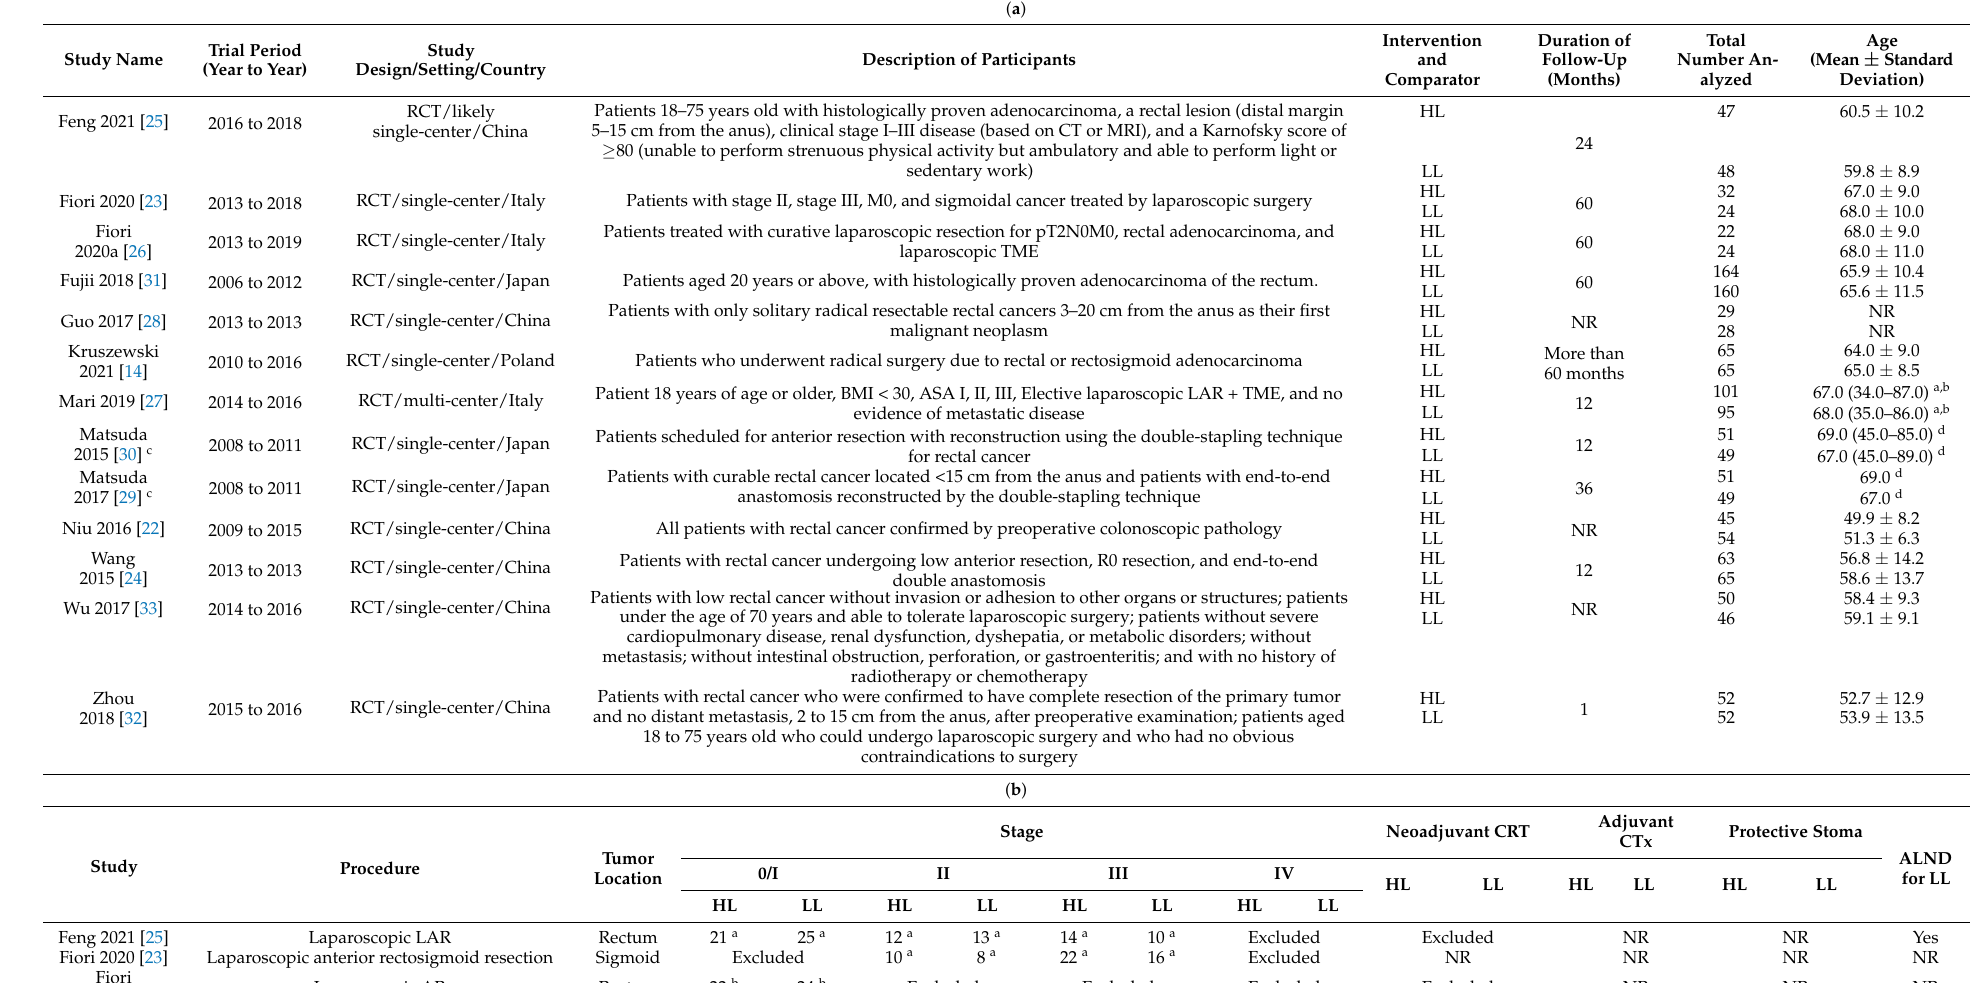
Table 1. ( a ) Baseline characteristics of included studies. ( b ) Baseline characteristics of included